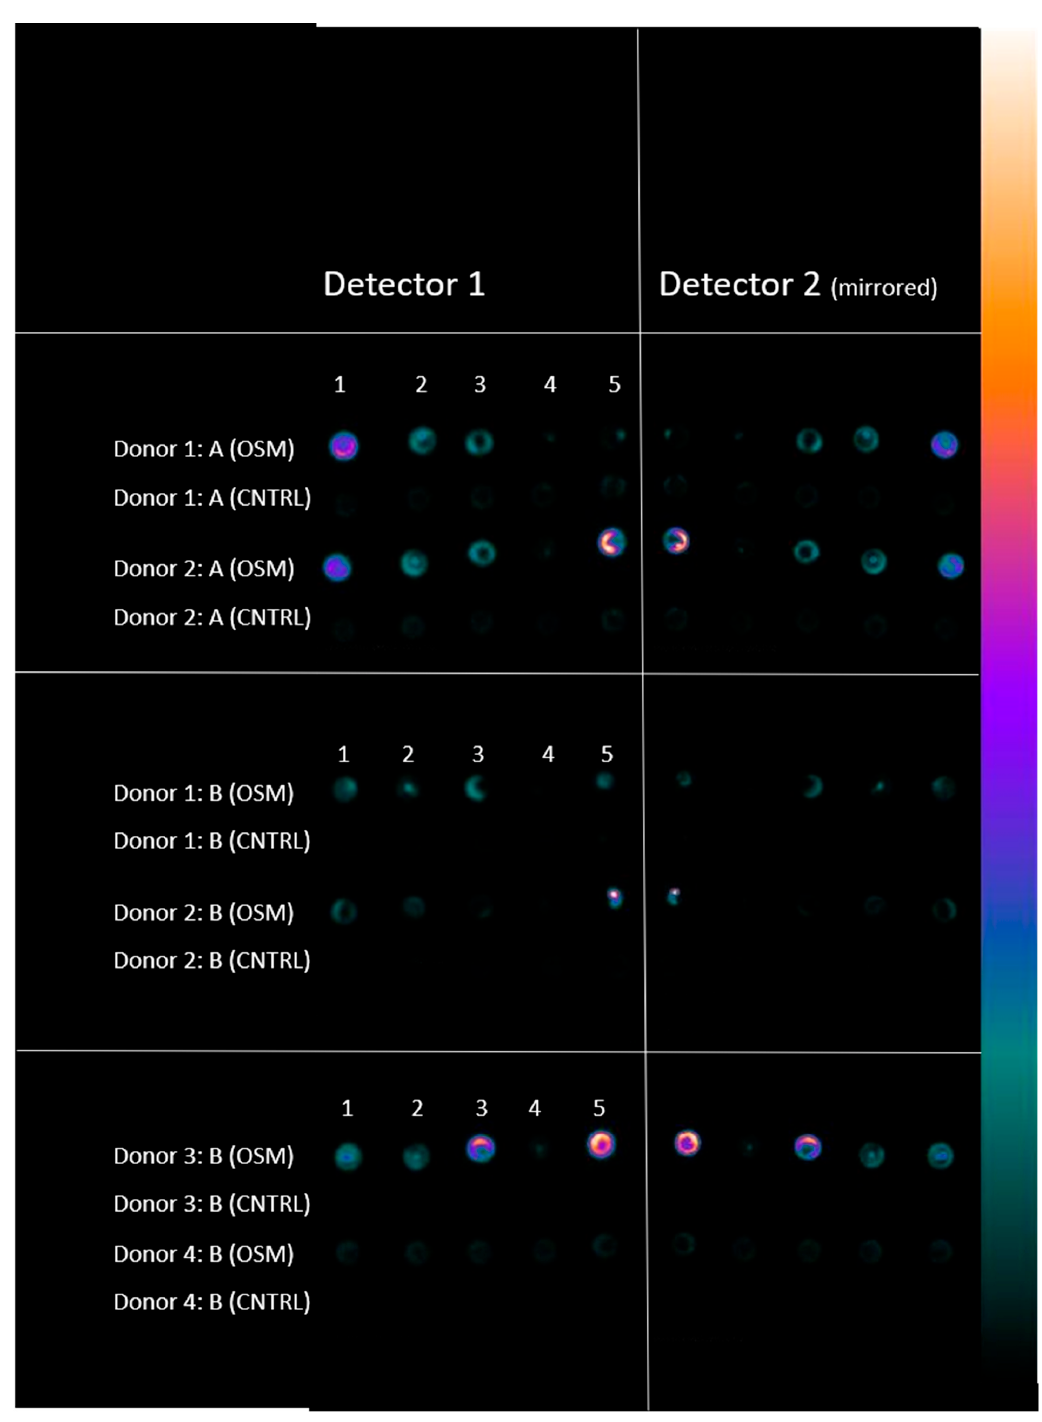
Figure 5. Gamma camera live image of the cell cultures during the acquisition of the tracer uptake after 180 s for Donors 1 and 2, expanded in DMEM LG (A), followed by differentiation in specific media according to the individual group (1–5) and for donors 1, 2, 3, and 4, expanded in α -MEM (B), followed by differentiation in specific media according to the individual group (1–5). OSM = osteogenic media, CNTRL = negative control group. Counts were acquired using detector 1, while detector 2 always displayed a mirrored image which was not analyzed.